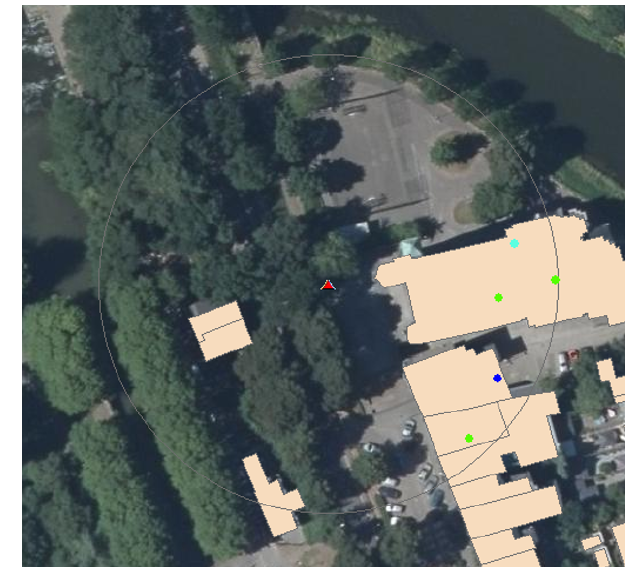
Figure 3. Example where a suspected outlier in the InSAR PS data strongly affects the estimated deformation at the NAP point. The outlier was identified by comparing the estimated rates from InSAR with rates estimated from NAP height time series.